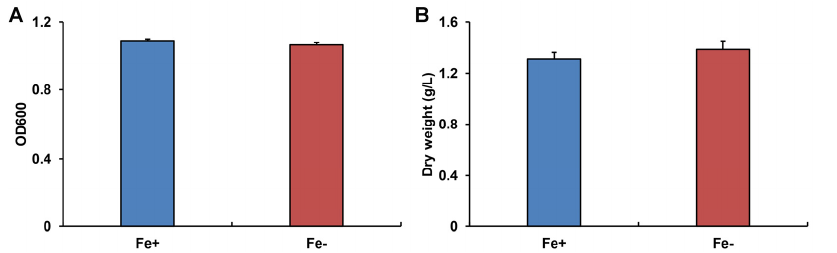
Figure 1. The absorbance ( A ) and dry weight ( B ) of Bacillus sp. WR13 after 24 h incubation in Fe-sufficient (Fe+) and Fe-deficient (Fe − ) conditions.